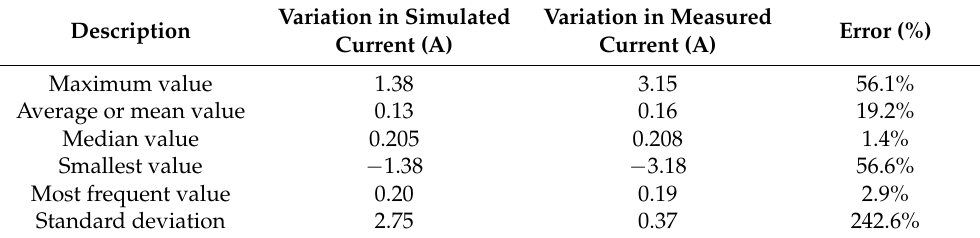
Table 11. Comparison between simulated and measured current—data statistics for motor M2. Description